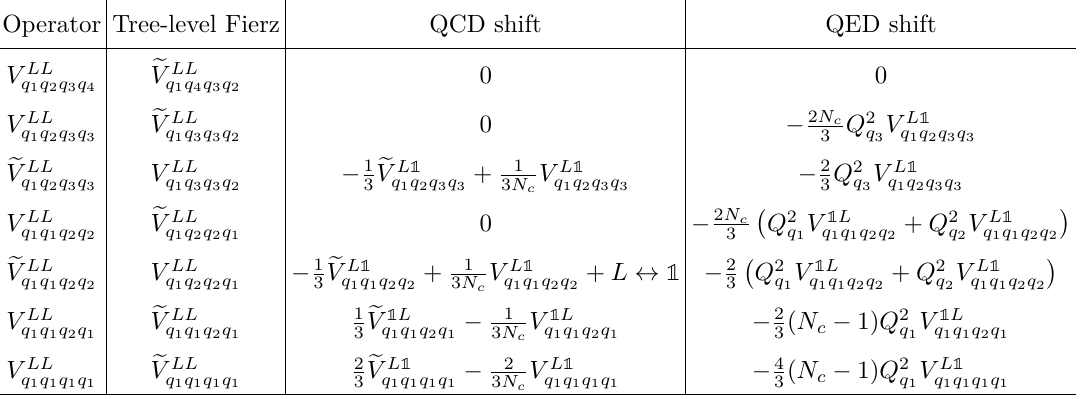
Table 1. Fierz transformations for four-quark γ µ P L ⊗ γ µ P L operators together with their one-loop QCD and QED shifts in the original BMU scheme.